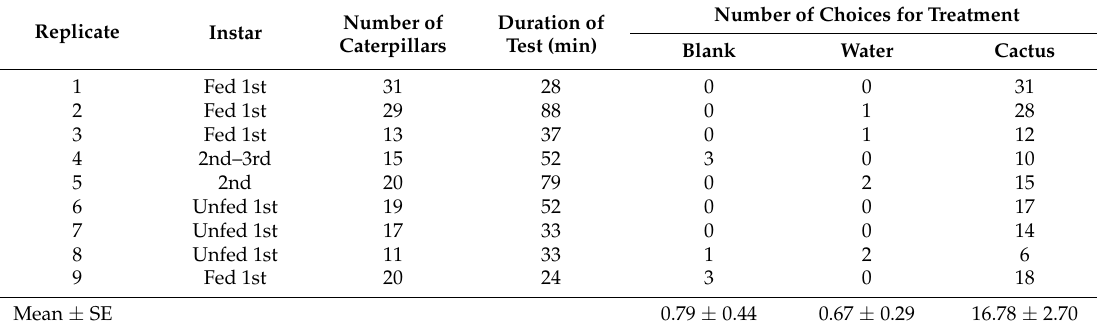
Table 4. Percent of time spent excavating and in other activities by groups of neonates of Cactoblastis cactorum.